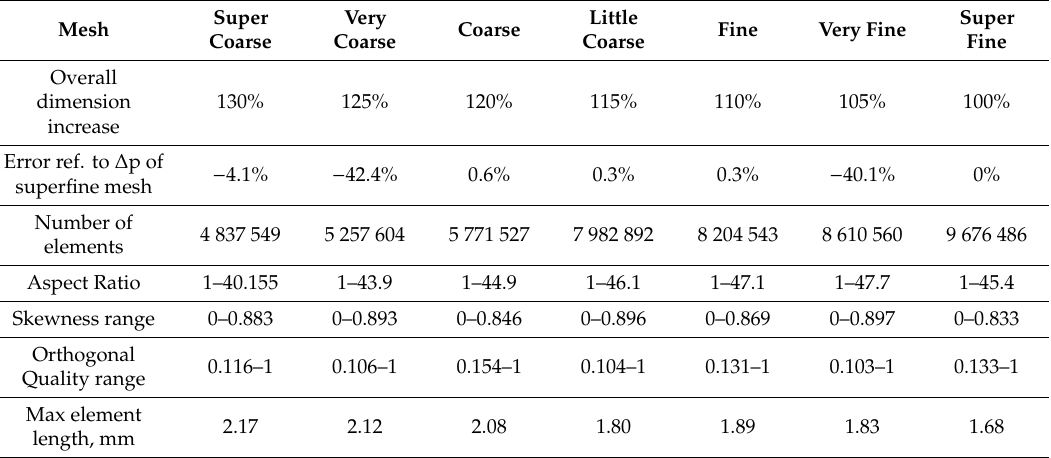
Table 1. Parameters of analyzed